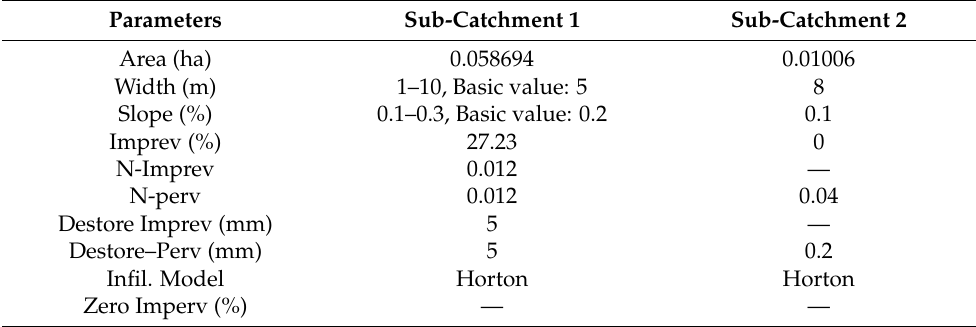
Figure 3. Schematic diagram of the study area: ( a ) onsite monitoring locations; ( b ) photograph of the vegetation retention tank onsite. Table 1. Storm water management model (SWMM) parameters used in the case